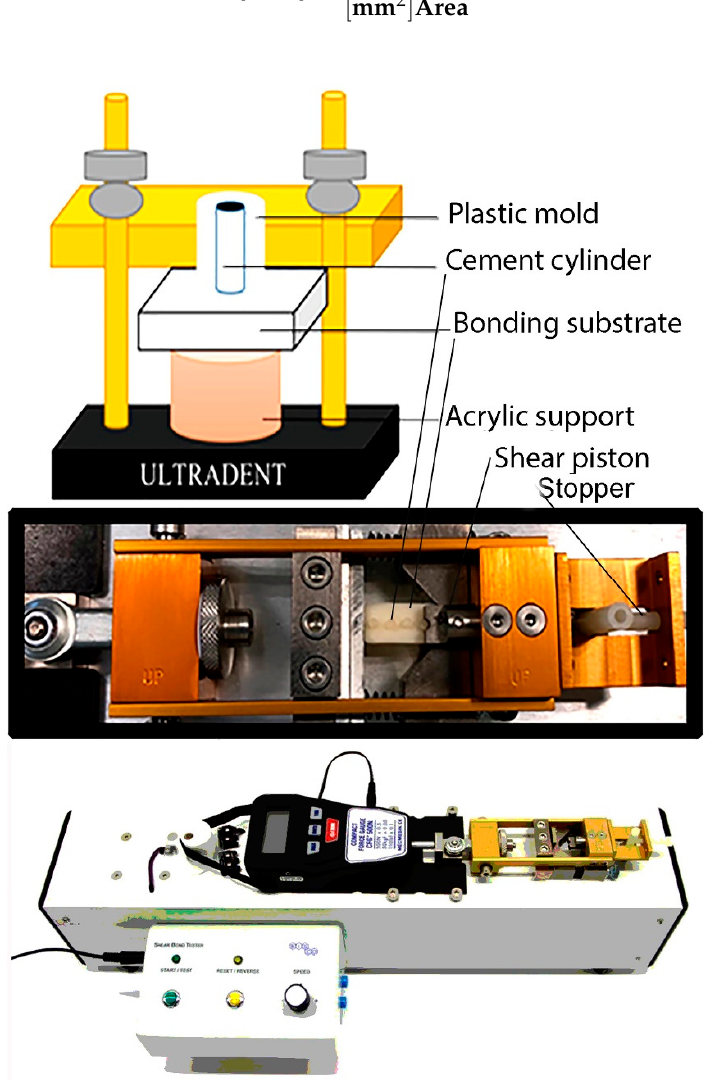
Figure 1. Schematic representation of the specimen preparation and shear bond strength test.